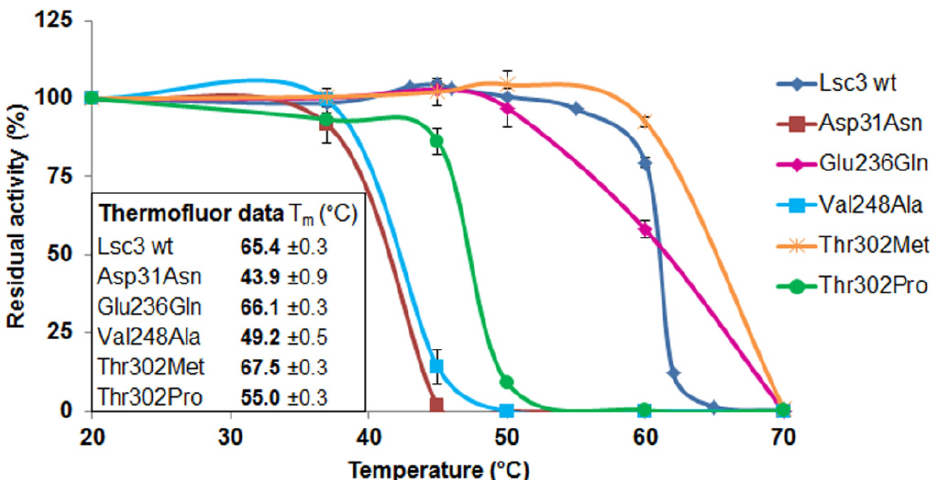
Figure 7. Thermal inactivation assay of purified wild-type Lsc3 and the mutant proteins Asp31Asn, Glu236Gln, Val248Ala, Thr302Met and Thr302Pro. After incubation of 5 μ M of a levansucrase in McIlvaine’s buffer (pH 6.0) at a selected temperature, its residual activity was measured according to release of glucose from 100 mM sucrose [4]. The activity of a preparation kept at 20 °C was used as reference for 100% of activity. Inner panel shows T values obtained by the Thermofluor assay. The mean values of at least two m parallel experiments and respective standard deviations are